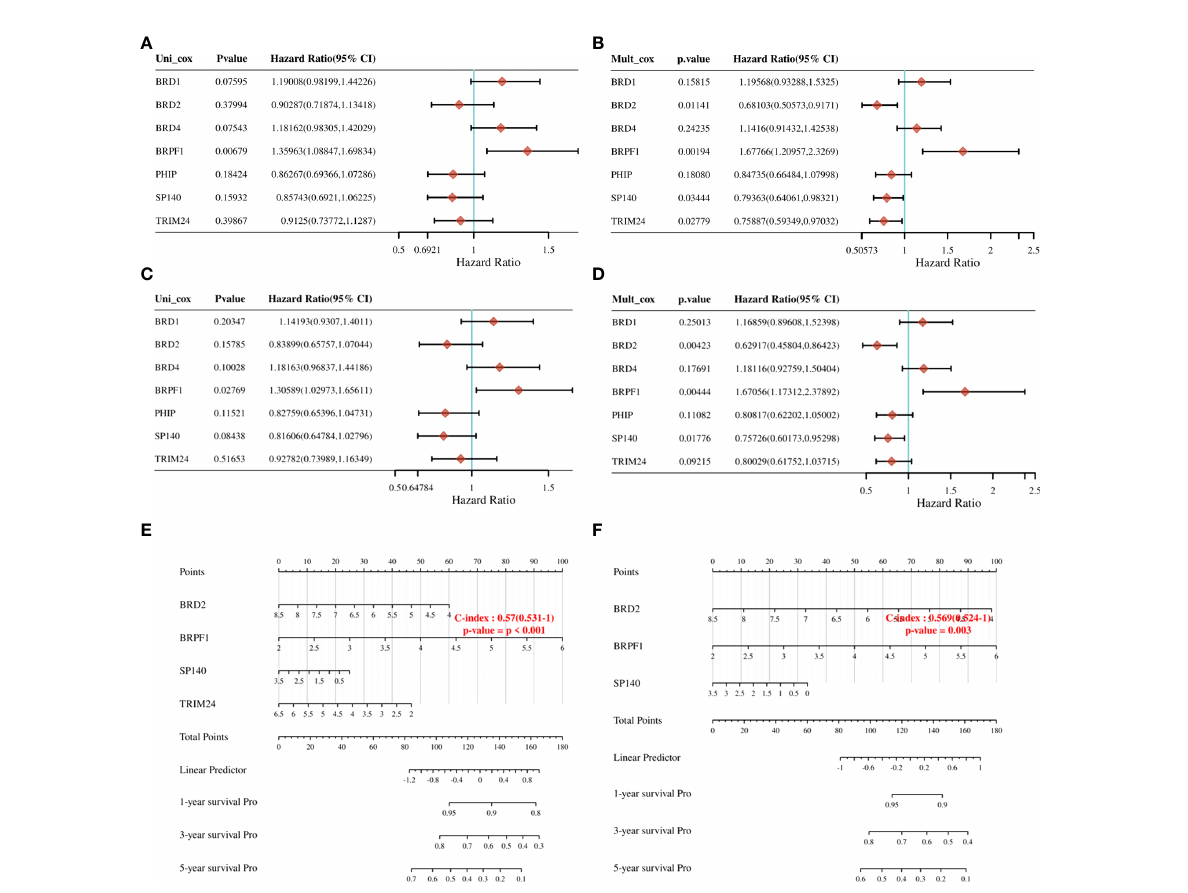
FIGURE 10 Prognostic value of seven expression signatures in OSC. (A) Prognostic values of seven signatures shown by forest plot of hazard ratios by Uni- Cox analysis for OS. (B) Prognostic values of seven signatures shown by forest plot of hazard ratios by Multi-Cox analysis for OS. (C) Prognostic values of seven signatures shown by forest plot of hazard ratios by Uni-Cox analysis for DSS. (D) Prognostic values of seven signatures shown by forest plot of hazard ratios by Multi-Cox analysis for DSS. (E) Nomogram survival prediction chart for predicting OS rates at 1, 3, and 5 years. (F) Nomogram survival prediction chart for predicting DSS rates at 1, 3, and 5